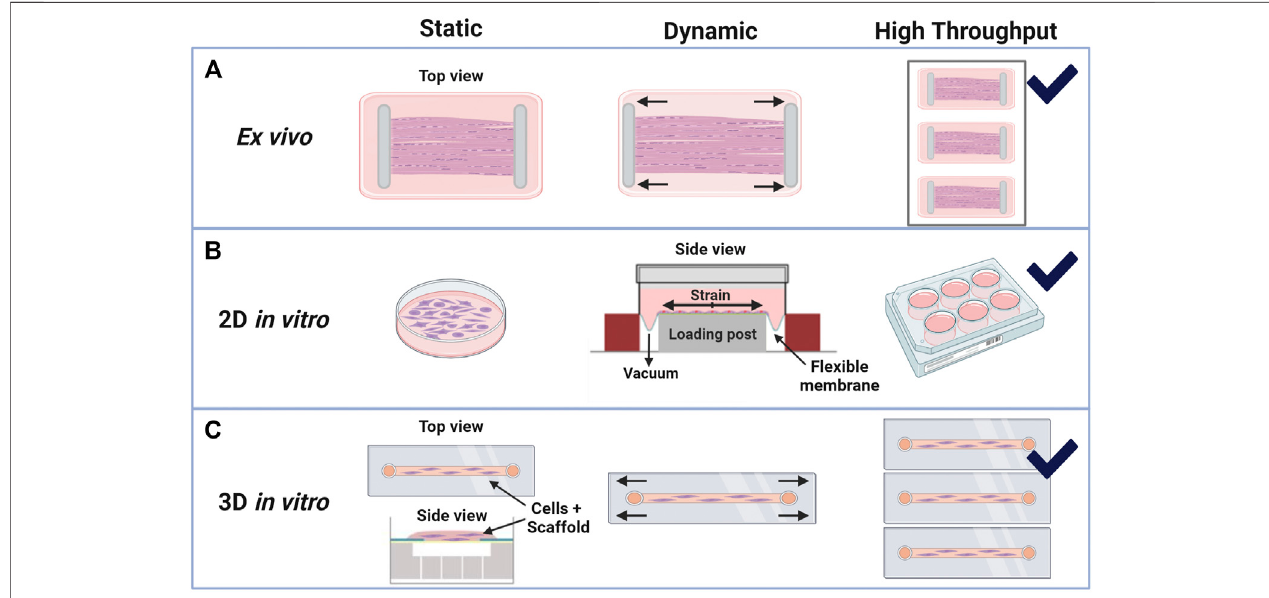
FIGURE 5 | Bioreactor schematics for in vitro and ex vivo systems with static or dynamic loading and high-throughput options. Created with Biorender.com. (A) Example exvivo systemsarecommonlydevelopedin-housewithwholetendonclampingsystemsthatcanbeuniaxiallystretchedundersetstrainsorloads(Wangetal., 2015; Tohidnezhad et al., 2020; Pedaprolu and Szczesny, 2021). (B) Tenocyte cell culture monolayers (2D in vitro systems) under static load, or no load, and dynamic loads have the greatest high-throughput capabilities. Dynamic loads on fl exible membranes may be produced by mechanical actuators or with vacuum pressure, as illustrated and modi fi ed from Flexcell International ’ s Tension System, Burlington, NC (Arnoczky et al., 2002; Fleischhacker et al., 2020; Gaut et al., 2020; Kubo et al., 2020). (C) Cell-seeded 3D constructs can be gel-like, as shown in the side view (modi fi ed from Flexcell ’ s 3D Tissue Train System), or like whole-tissue if decellularized constructs are used. These 3D systems are generally bound by the dimensions of the material or well in which they are contained, yet there is fl exibility in load types (tensile, shear, etc.) that can be analyzed (Zhang et al., 2015; Patel et al., 2017; Wang and Thien, 2018; Sawadkar et al., 2020; Pentzold and Wildemann, 2022).